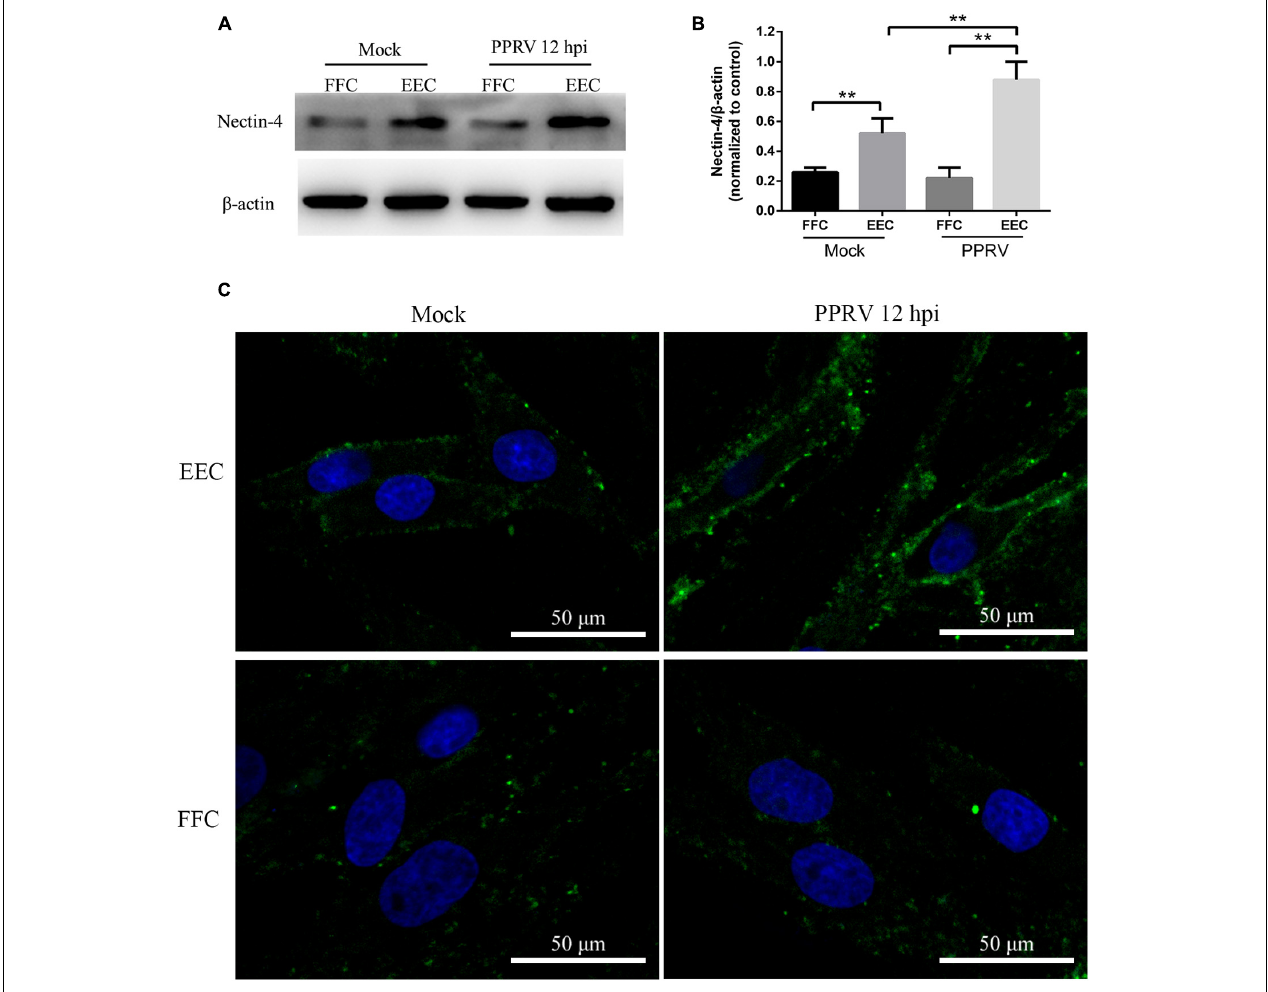
FIGURE 8 | Receptor nectin-4 expression in EECs and FFCs inoculated with PPRV. (A) Western blot analysis of viral receptor expression in mock and PPRV infected cells. (B) The relative quantification of the receptor proteins was determined by densitometry against β -actin. (C) CLSM analysis of anti-nectin-4 (green) and DAPI (blue) in mock and PPRV infected cells. The bars indicate the mean ± SD from three independent experiments. SD, standard deviation; ∗ P < 0.05; ∗∗ P <